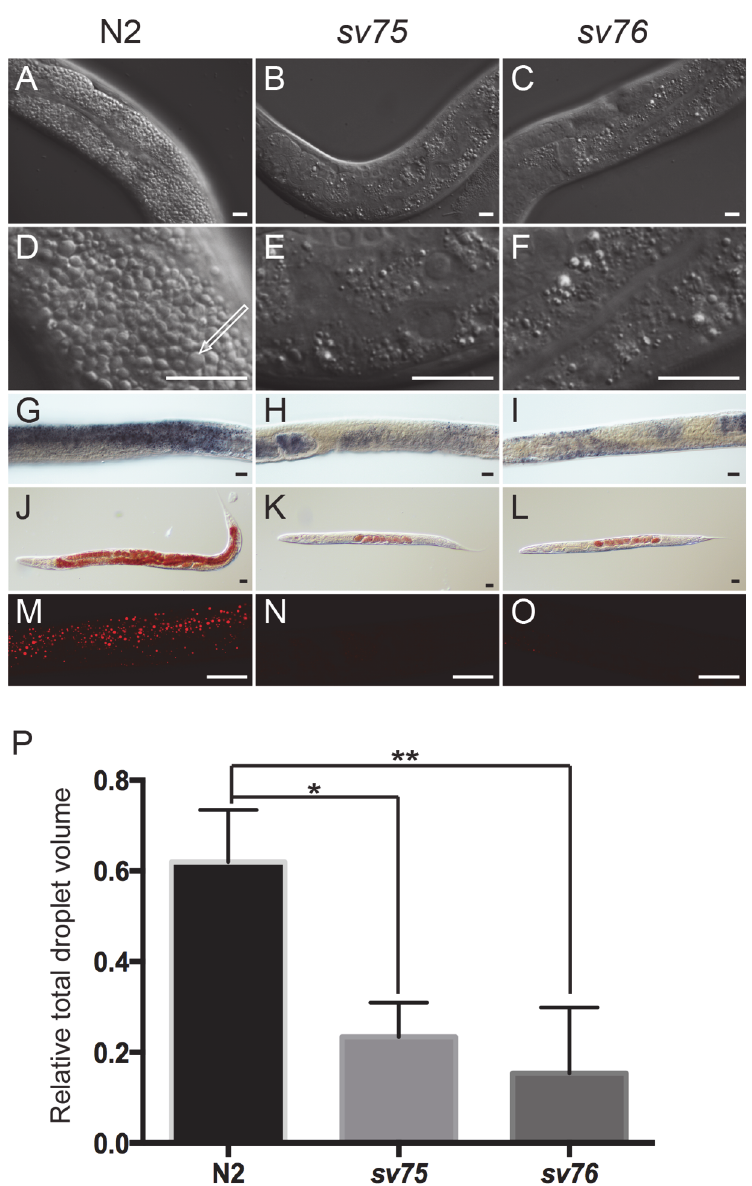
Fig 1. sv75 and sv76 cause decreased fat accumulation in the intestine. Representative micrographs of parts of young adult hermaphrodite worms viewed with differential interference contrast (DIC) (A-L) or fluorescence (M-O) optics. Scale bars are 10 μ m. A-F show parts of the intestines of living worms; G-I show fixed worms stained with the lipophilic dye, Sudan Black. J-L show fixed worms stained with the lipophilic dye, Oil Red O. M-O show fixed worms stained with the fluorescent lipophilic dye, Nile Red. The arrow in D indicates a lipid droplet. P shows quantification (in arbitrary units) of the combined volume of Nile Red-stained droplets relative to tissue volume in wild type and in the mutants (Materials and Methods). Error bars indicate standard errors of the means. * and ** indicate significant differences between the means determined by one-way ANOVA ( σ = 0.05) and Dunnett's multiple comparisons